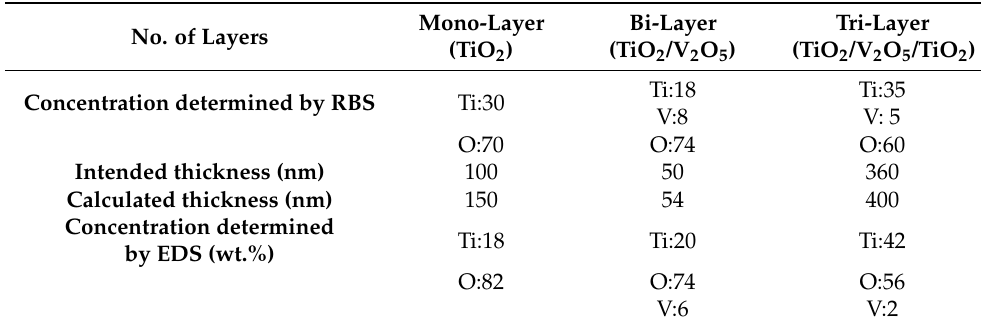
Table 1. Concentrations of mono-, bi-, and tri-layers as determined by RBS and EDS, and intended and determined thicknesses of the individual